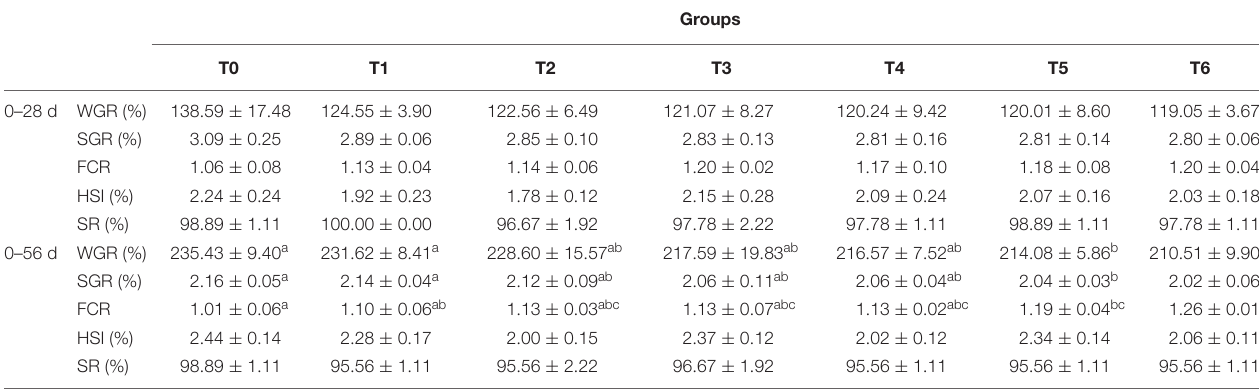
TABLE 2 | Effects of histamine on growth performance of grouper ( Epinephelus coioides ).